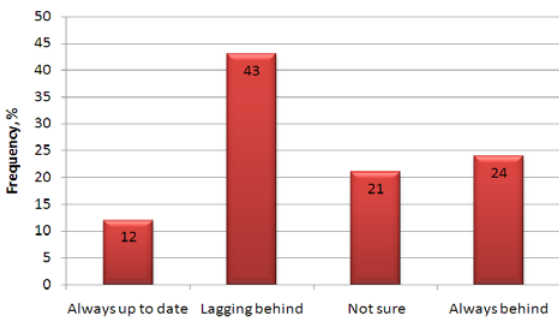
Fig. 14. Participants’ perception of their access to farming technology